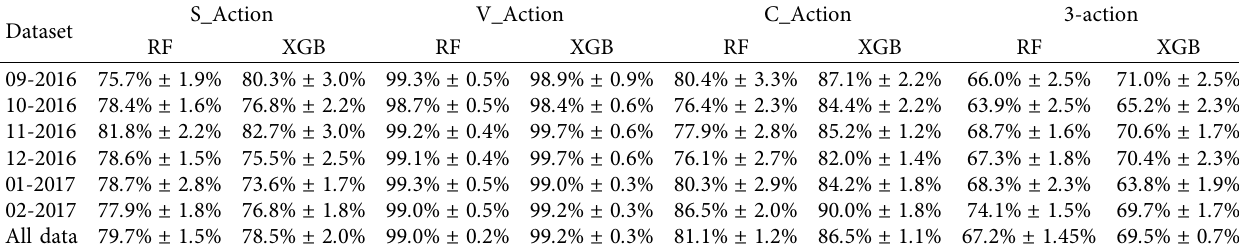
Table 7: Predictive accuracy of predictive models: speed action, vertical action, course action, and 3-action. Dataset